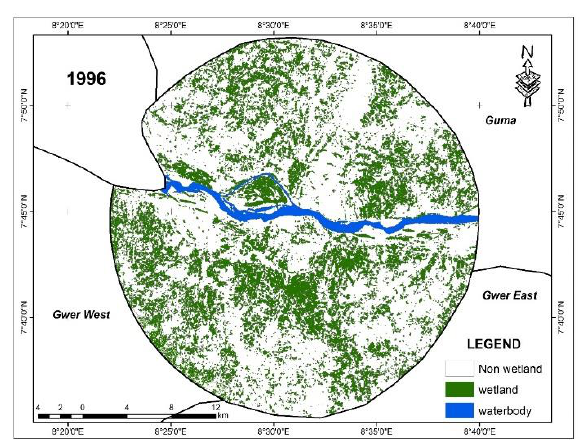
Figure 7. Wetland cover in 1996.